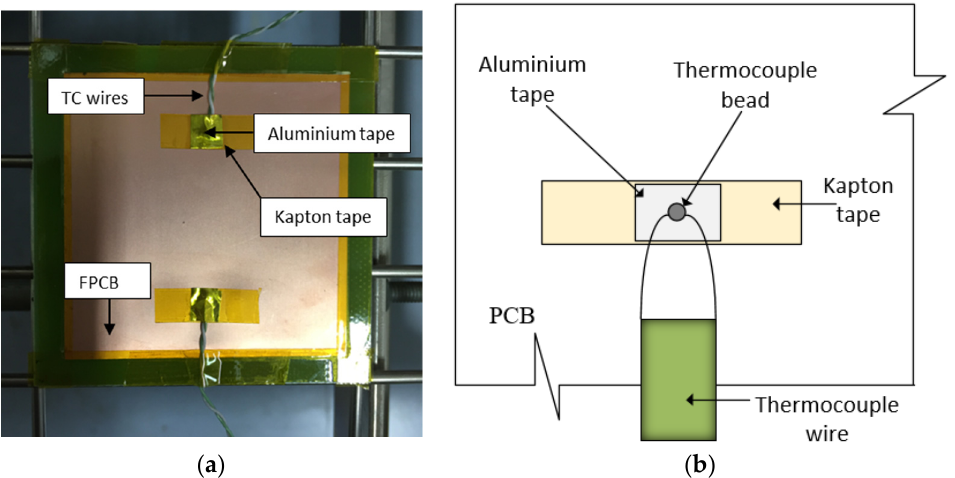
Figure 7. ( a ) Actual locations of the thermocouples and ( b ) attachment method of thermocouples on the surface.